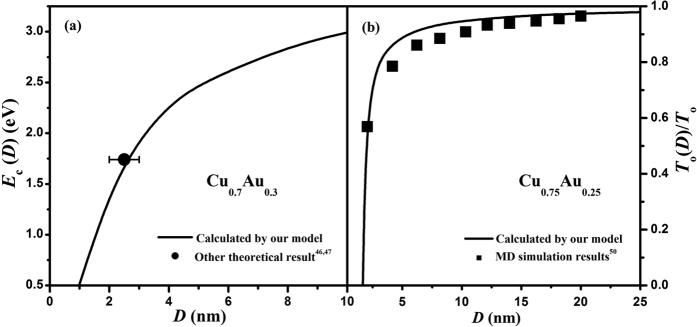
(a) Ec(D) of Cu0.7Au0.3 nanoalloys as a function of D in terms of Eq. (8) where the bulk cohesive energy of Cu0.7Au0.3 is calculated by Fox equation and the symbol (●) is other theoretical result4647. (b) To(D)/To of Cu0.75Au0.25 nanoalloys as a function of D in terms of Eq. (9) where the symbol (■) denotes available MD simulation results50.